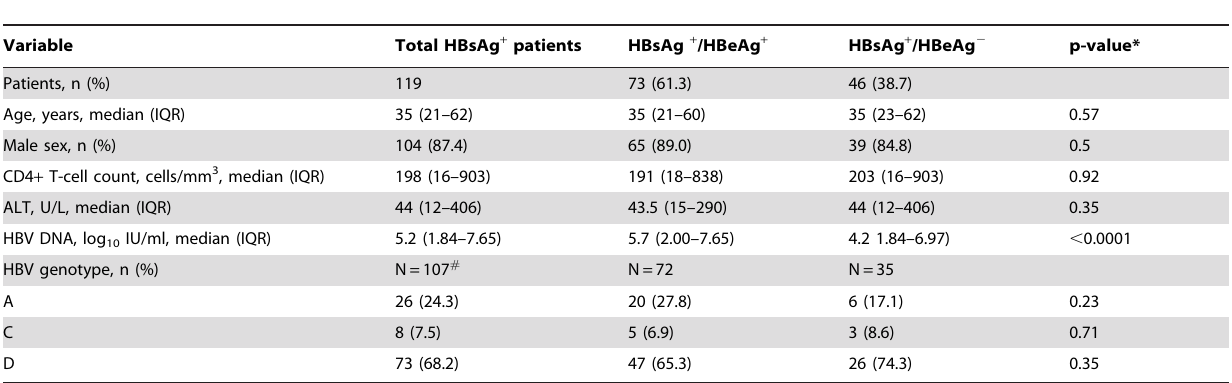
Table 2. Comparison of baseline parameters between HBeAg positive and negative patients among the total 119 HBsAg positive